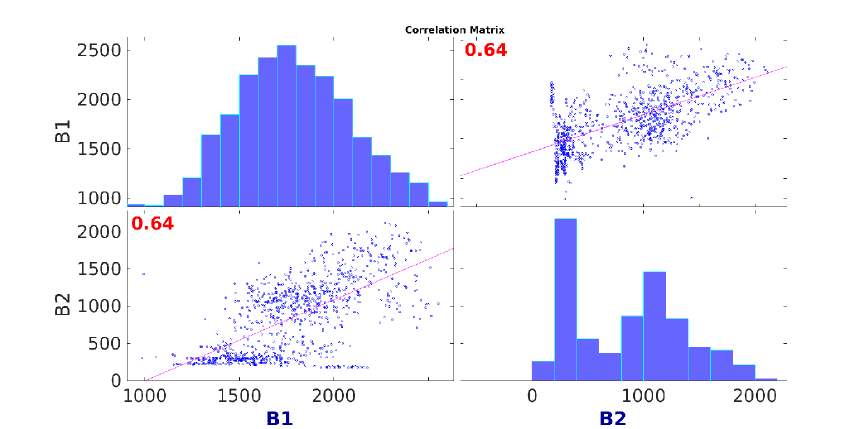
Figure 6. Energy consumption correlation between days for Buildings B 1 and B 2 .